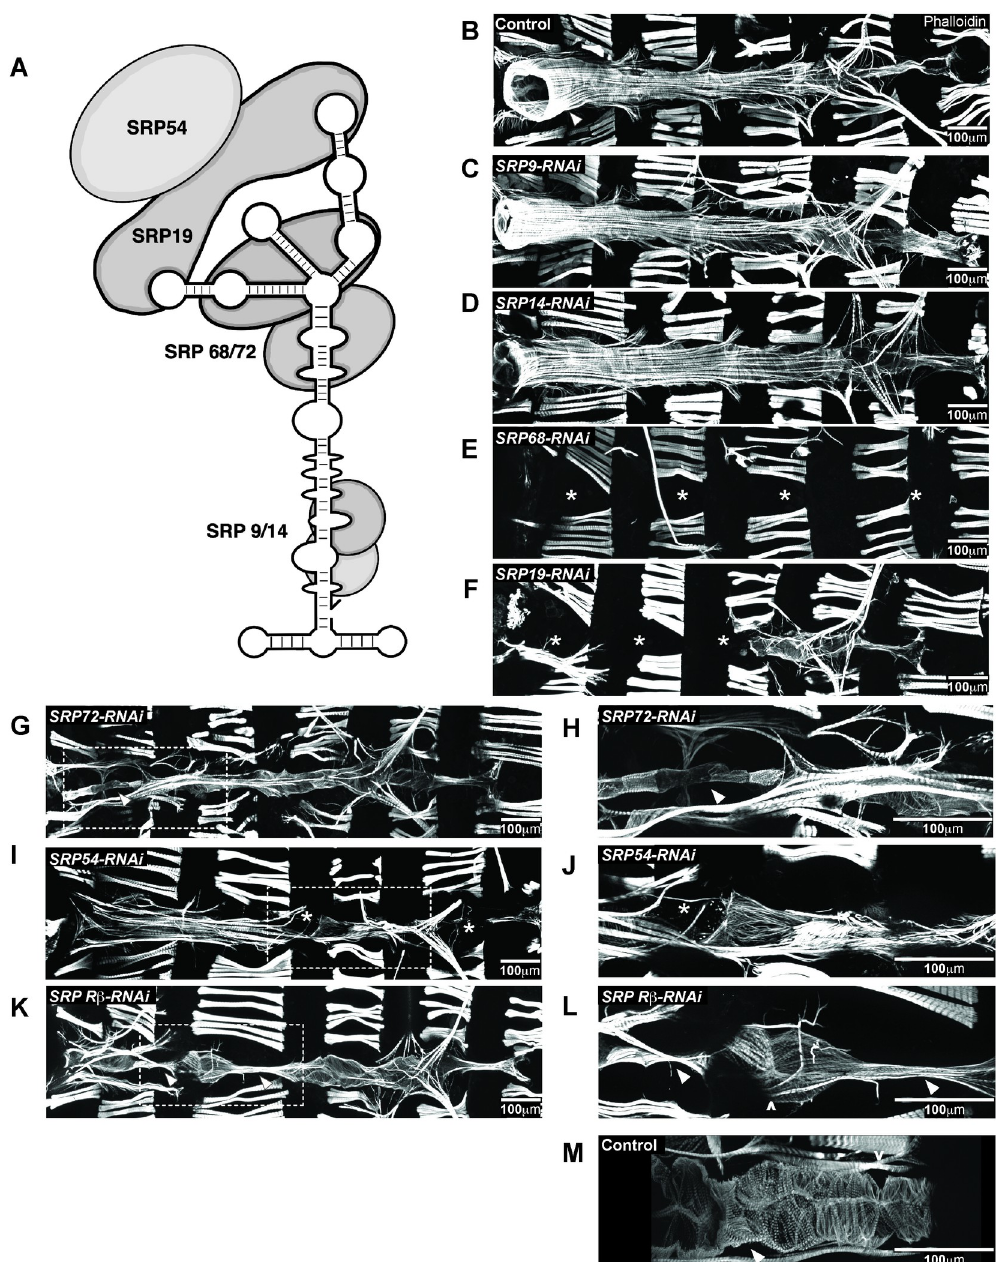
Fig 6. Knockdown (KD) of SRP subunits in the Drosophila heart caused distinct heart defects. A , The Signal Recognition Particle (SRP) is composed of an RNA molecule holding together 6 SRP subunits. B-M, Individual SRP subunits were KD by RNAi using the heart specific driver Hand4 . 2 -GAL4 and adult flies were stained with phalloidin to determine their contribution to heart structure and development. � indicates missing heart segments or cardiomyocytes. KD of C , SRP9 and D, SRP14 subunits, responsible for elongation arrest during translation, did not lead to gross alterations in heart structure and were comparable to B, controls. Arrowhead in control image point to the conical chamber. E , KD of SRP68 led to complete loss of the heart. G, Interestingly, KD of SRP72, a binding partner to SRP68 led to the presence of a heart tube. H, Higher magnification of the conical chamber, marked by an arrowhead, showed that the conical chamber was constricted compared to controls ( B ), and resembled a larval aorta. F , KD of SRP19, led to a partial heart phenotype, where the anterior region of the heart was absent but the posterior end remained. I , KD of SRP54 led to a heart tube but with missing heart cells (indicated by asterisks) in random regions of the heart. J , Higher magnification of missing cardiomyocyte. K , KD of the SRP Receptor- β , a subunit of the receptor anchored to the ER membrane that binds to the SRP-ribosome-nascent chain complex, led to segments of the heart, usually the valves, that were constricted and larval like, indicated by the arrowhead. L ,